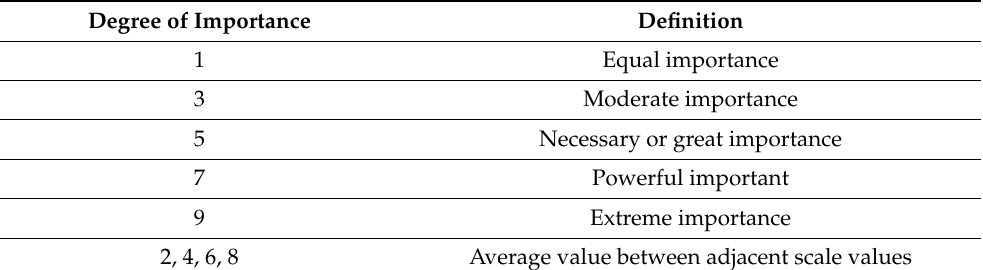
Table 2. The scale of relative importance. Degree of